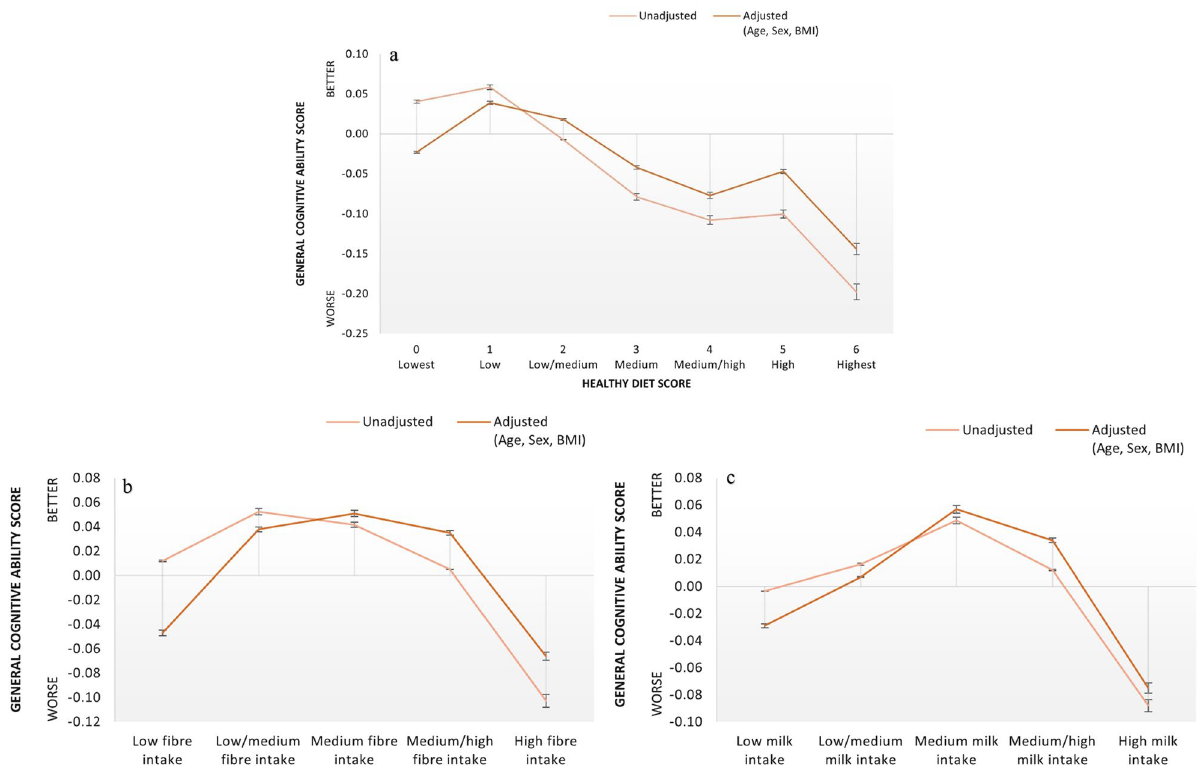
Figure 1. Mean cognitive ability scores according to ( a ) healthy diet scores, ( b ) fibre intake groups, ( c ) milk intake groups (bars represent 95%